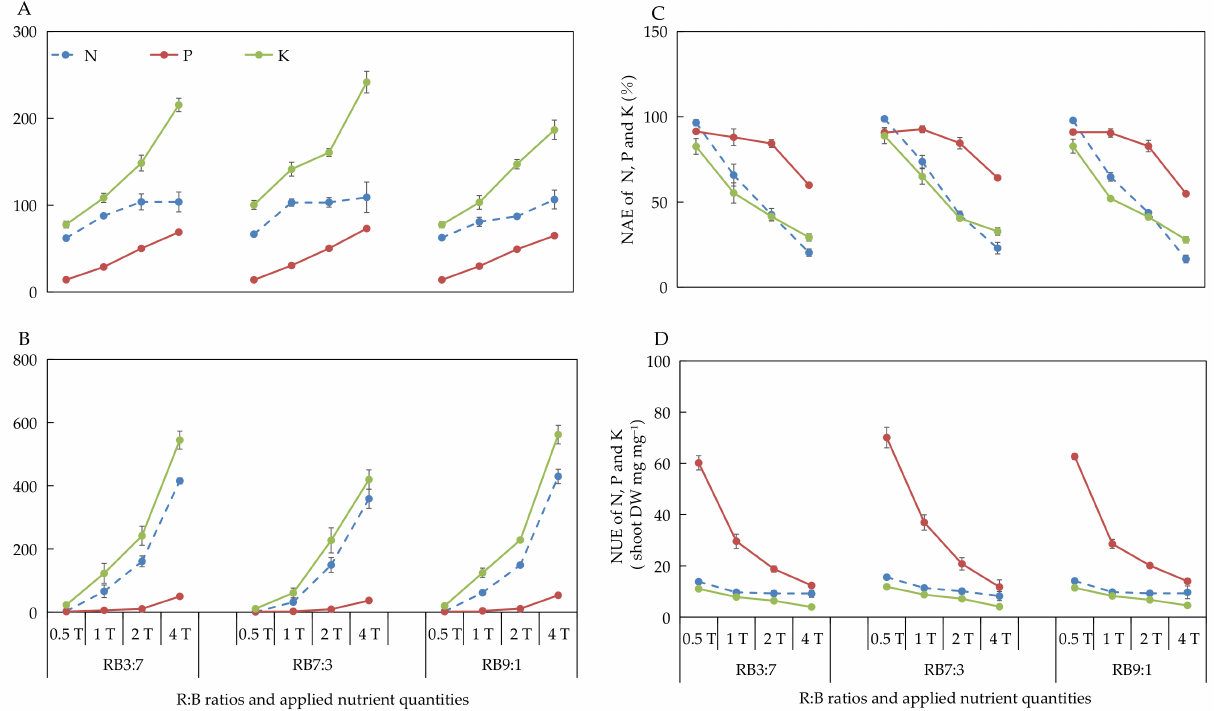
Figure 3. Nutrient absorption (NA) ( A ), nutrient waste (NW) ( B ) from producing 1 g shoot dry weight, nutrient absorb efficiency (NAE) ( C ), and nutrient use efficiency (NUE) ( D ) of shoot dry weight of N, P, and K after 20 days of cultivation under different ANQ treatments and R:B ratios. 0.5T, 1T, 2T, and 4T represent 4 different ANQ treatments. RB3:7, RB7:3, and RB9:1 represent the R:B ratios of 7:3, 3:7, and 9:1, respectively. The error bars represent SEs (n =